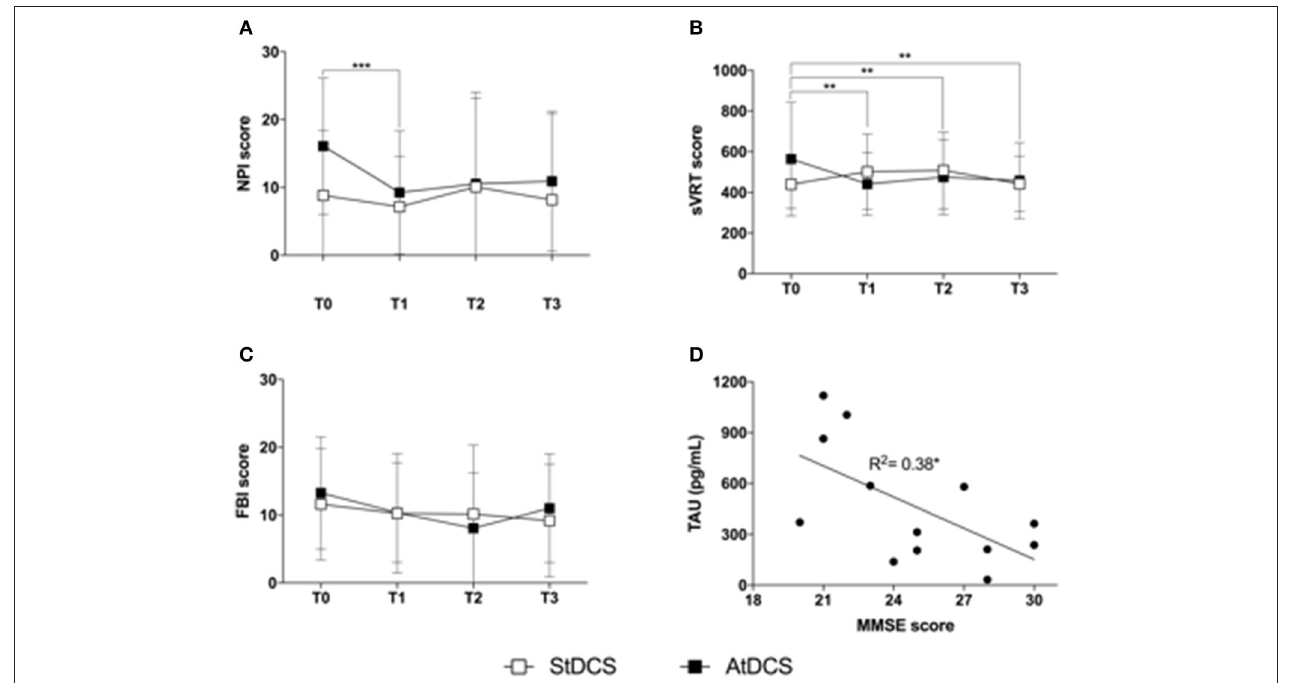
FIGURE 2 | Findings on clinical variables (A) . Effect of Anodal (black squares) and Sham (white squares) tDCS on the Neuropsychiatric Inventory (NPI). Squares represent the average NPI score on the 12 subjects analyzed, at T0, T1, T2, and T3. Error bars are standard deviations. *** p < 0.01 at the post-hoc Wilcoxon signed ranked test with Bonferroni correction (significant); (B) . Effect of Anodal (black squares) and Sham (white squares) tDCS on the simple Visual Reaction Time (sVRT) test. Squares represent the average sVRT score on the 12 subjects analyzed, at T0, T1, T2, and T3. Error bars are standard deviations. ** p < 0.01 at the post-hoc Wilcoxon signed ranked test with Bonferroni correction (significant) (C) . Effect of Anodal (black squares) and Sham (white squares) tDCS on the Frontal Behavioral Inventory (FBI-A). Squares represent the average FBI-A score on the 12 subjects analyzed, at T0, T1, T2, and T3. Error bars are standard deviations (D) . Scatter plot of the correlation between TAU protein (pg/mL) and MMSE score. The line represents the estimated linear regression. * p <